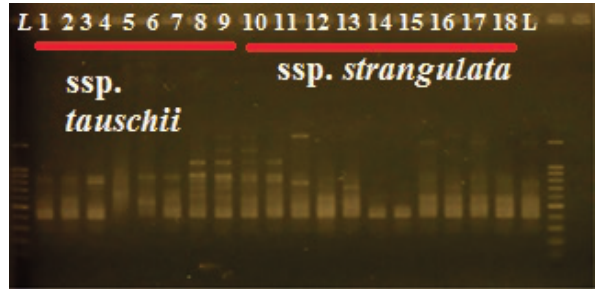
Figure 1. Electrophoresis gel of studied ecotypes from DNA frag- ments produced by SCoT-19(Population numbers according to Table 1).